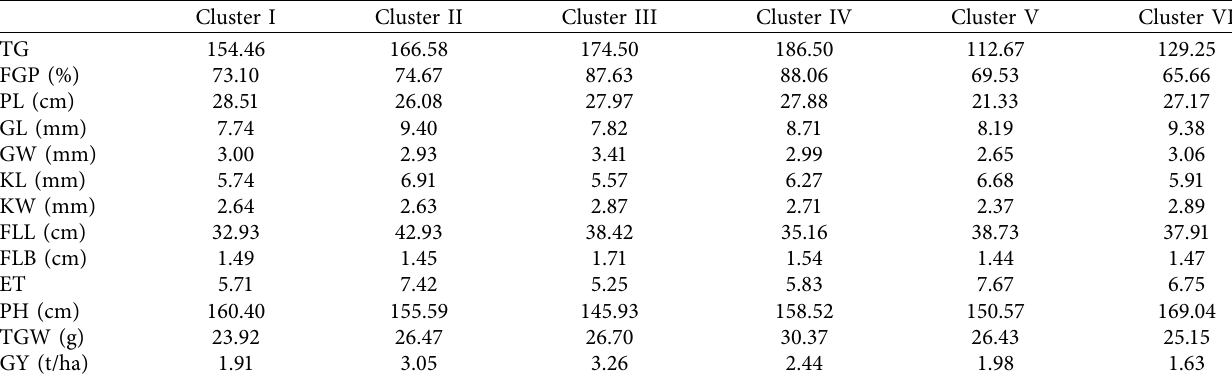
Table 5: Mean performance of different traits in each